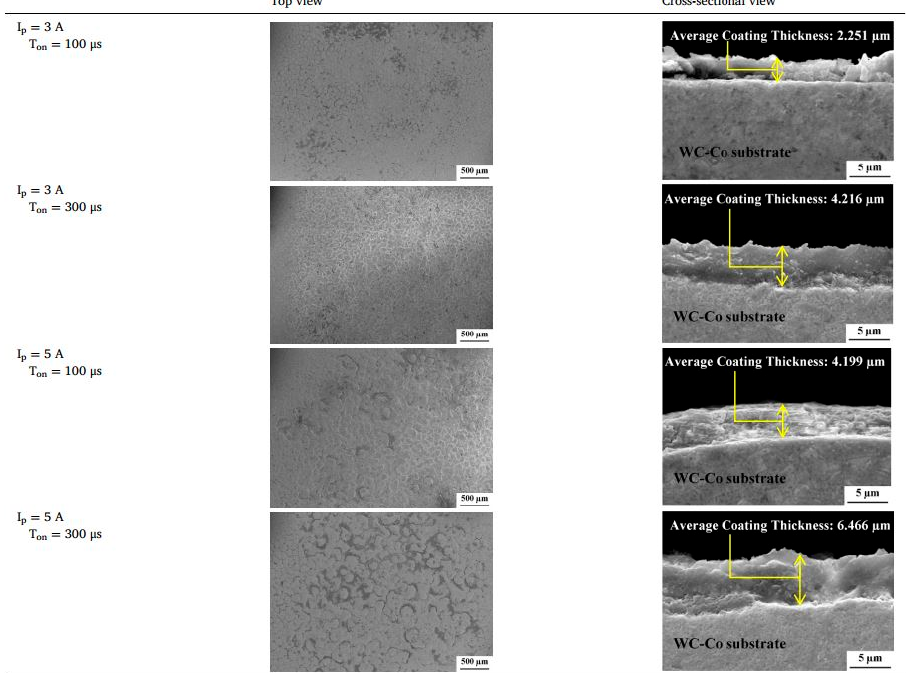
Figure 21. Top and cross-section view of coating [163].